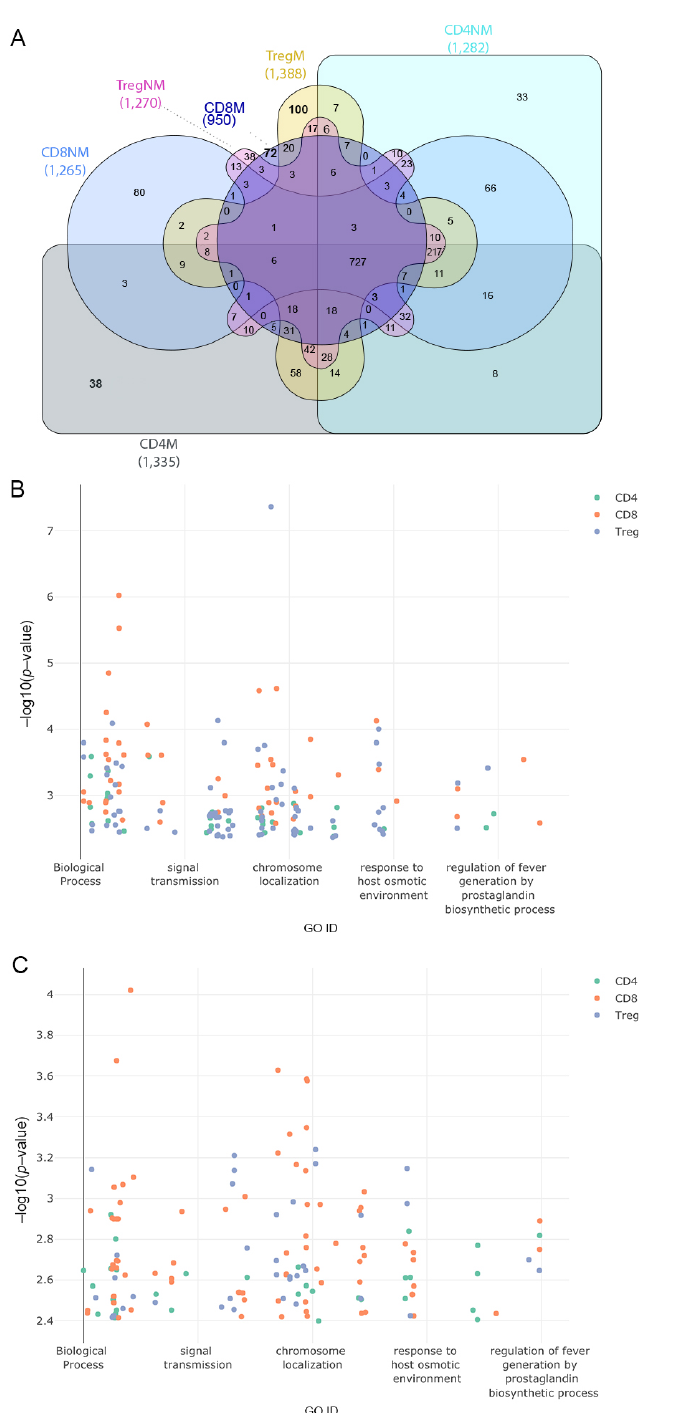
Figure 4. Gene ontology terms associated with exclusive pathways among all the samples. ( A ) Com- parison of common biological processes across all the T-cell subpopulation. ( B ) Scatter plot of exclusive GO terms in biological processes in a two-dimensional space representing on the x -axis a semantic cross-match to the gene ontology database and on the y -axis the p -value ( − log10 p -value) of the associated genes to the functions. Colors represent the subpopulation of the cell that corre- spond to the GO terms for samples with malignant origin. ( C ) Same as in ( B ) but for samples with nonmalignant origin. Interactive plots are available at https://tumourtcells.github.io/Fig-4B/ and https://tumourtcells.github.io/Fig-4C/ (accessed on 20 March